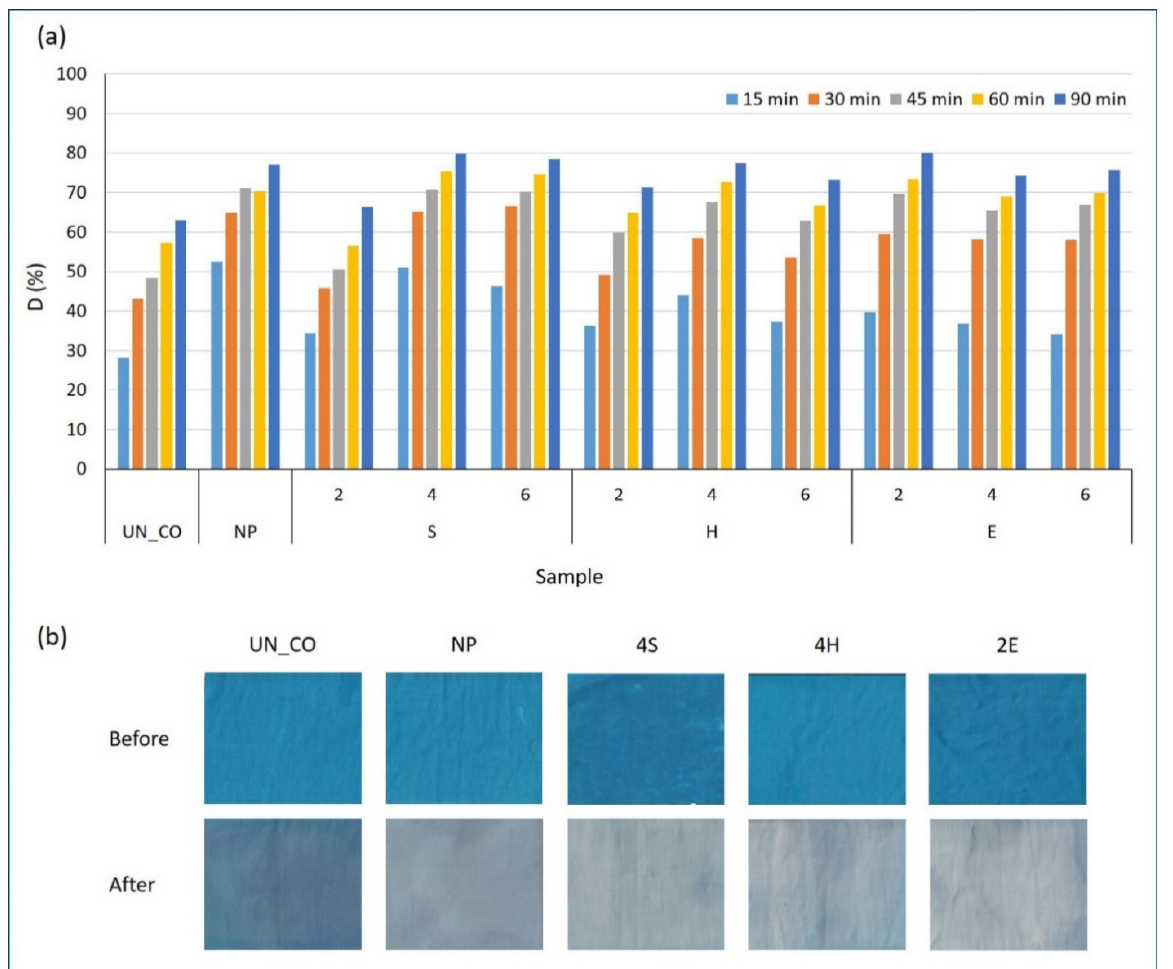
Figure 7. Degradation degree, D, of MB after the exposure of the studied samples to light ( a ) and selected images of MB-stained samples before (top) and after (bottom) 90 min ( b ) of illumination under a visible xenon arc lamp with a radiation intensity of 1.67 W/cm 2 .